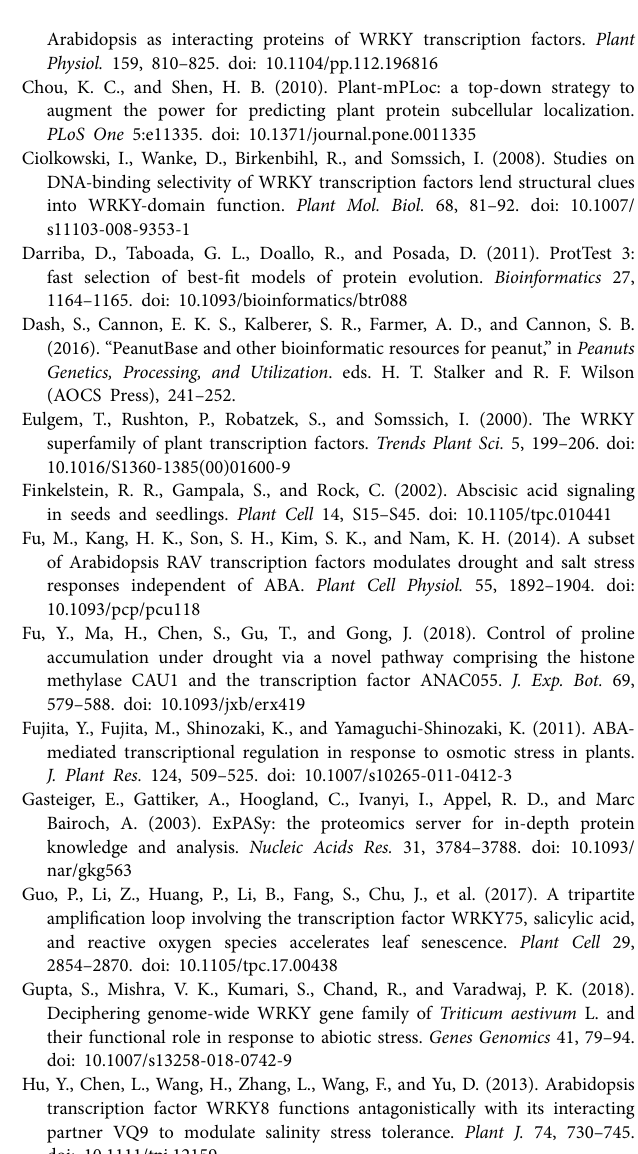
Supplementary Table S1 | Quantitative real-time PCR primers. Supplementary Table S2 | W-box element and subcellular localization of downstream genes. Supplementary Table S3 | Protein–protein interaction sequences. Supplementary Table S4 | Common interaction between proteins and AdWRKYs. Supplementary Table S5 | Specific interaction between proteins and AdWRKYs. Supplementary Figure S1 | The maximum likelihood tree constructed using WRKY domains. Supplementary Figure S2 | The maximum likelihood tree constructed using full-length WRKY